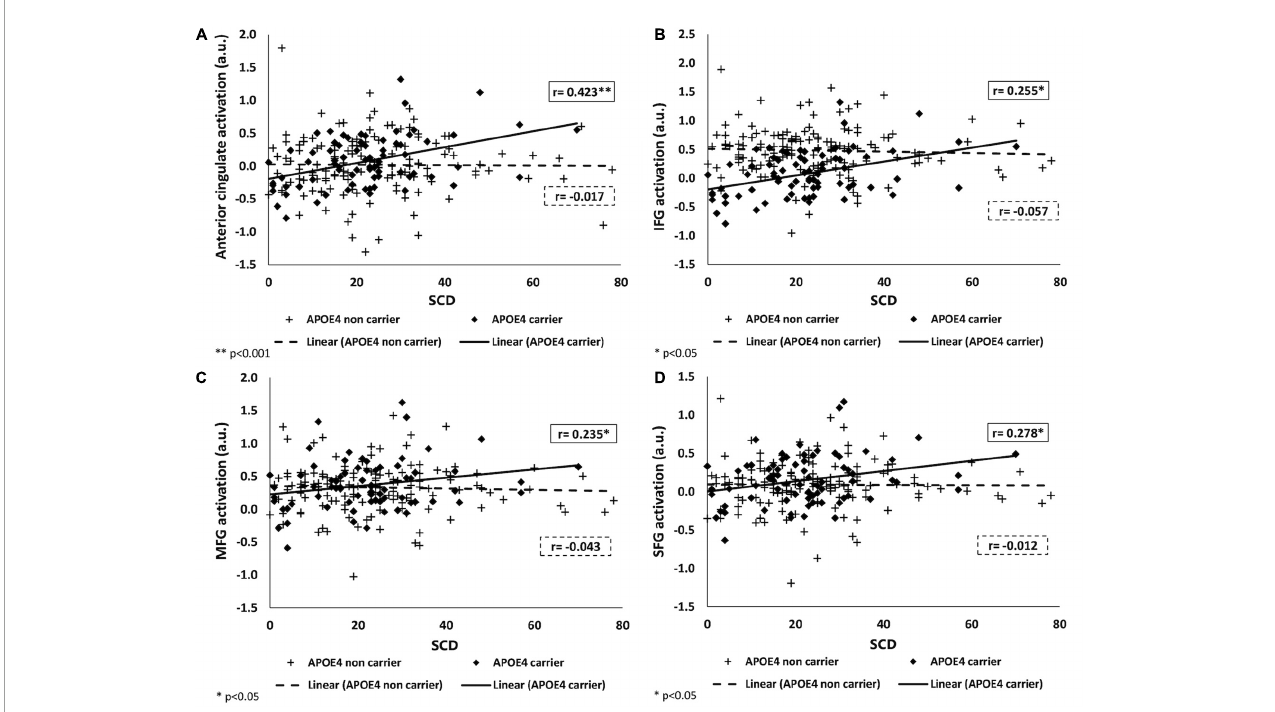
FIGURE2 Associations of SCD with brain activation in APOE ε 4 carriers and non-carriers. Positive association between BOLD signal intensity during a working memory task and SCD among APOE ε 4 carriers (shown as black) and no association among APOE ε 4 non-carriers (shown as dashed-line) in the anterior cingulate (A) , IFG (B) , MFG (C) , and SFG (D) . SCD, subjective cognitive decline; IFG, MFG, SFG, inferior, middle, and superior frontal gyri; APOE ε 4 , apolipoprotein E, alleles ε 34 or ε 44.